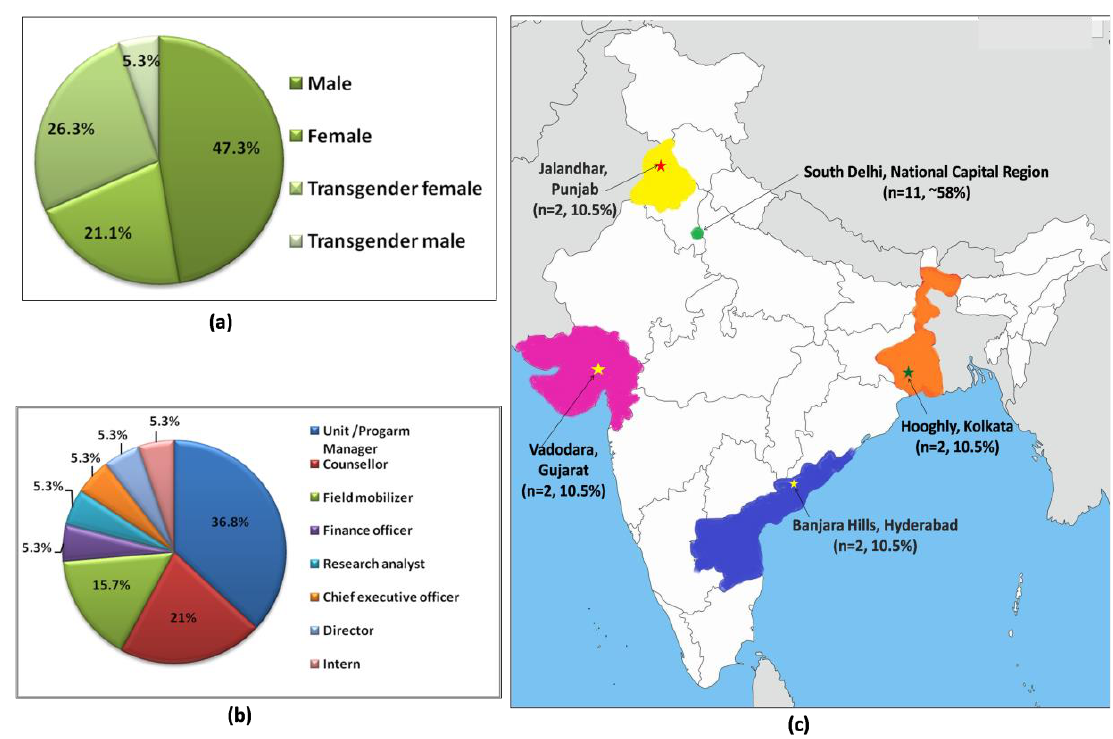
Figure 1. Classification of the participants based on ( a ) gender, ( b ) work profile, and ( c ) the geograph- ical distribution of their